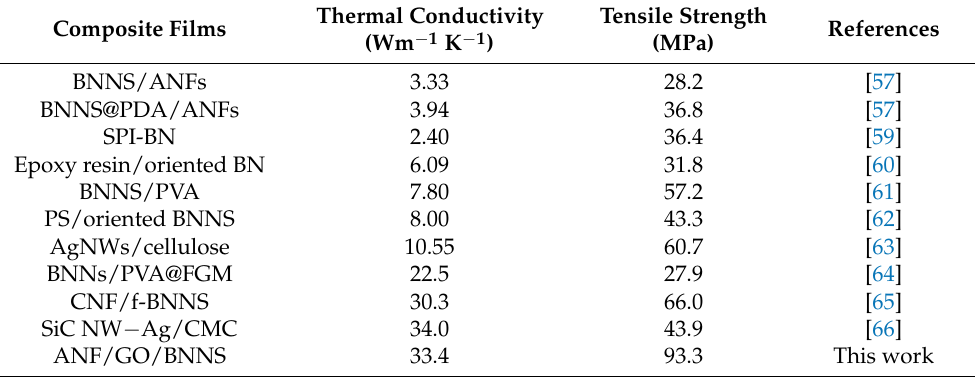
Table 1. Comparison of in-plane thermal conductivity and tensile strength of ANF/GO/BNNS composite film with other composite films reported in the